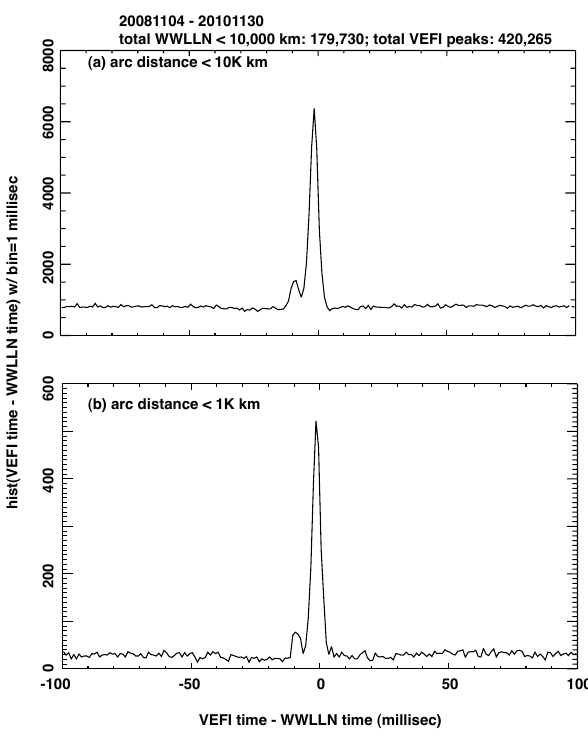
Fig. 14. Histograms of VEFI peak time minus WWLLN stroke time, after correction for WWLLN stroke’s propagation to the satel- lite in two path segments: First, from the stroke location to the subsatellite point in the Earth-ionosphere waveguide, at speed c, and second, vertically upward to the satellite as an oblique electron whistler. (a) Including WWLLN stroke locations out to 10000km from the subsatellite point. (b) Including WWLLN stroke locations out to 1000km from the subsatellite point. The histogram bins are 1-ms